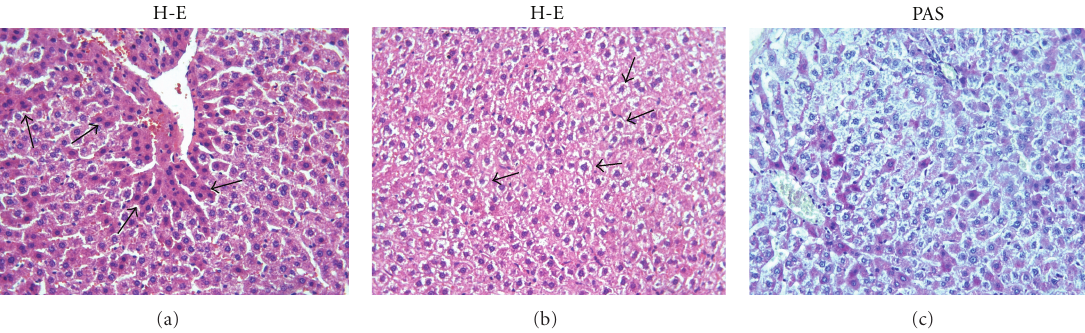
Figure 2: (a) Hepatocytes with eosinophilic cytoplasm (arrows) are observed in Mtx group. (b) Cellular swelling in hepatocytes (arrows) is noticed in Mtx group. (c) Marked reduction in glycogen content in Mtx group.